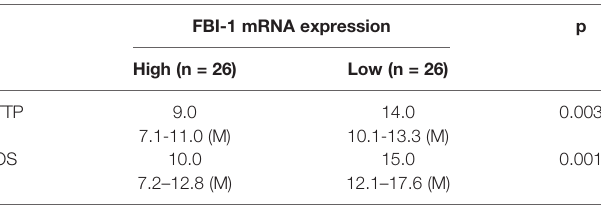
TABLE 1 | FBI-1 expression and clinical outcome of Sorafenib treatment.